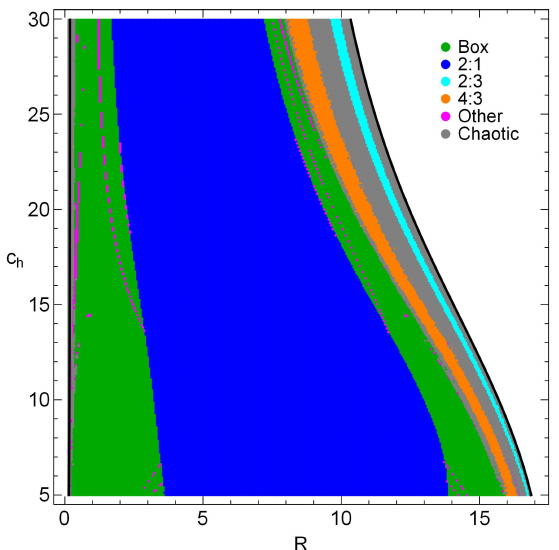
Fig. 7. Orbital structure of the ( R; c h ) plane. This diagram gives a detailed analysis of the evolution of orbits starting perpendicularly to the R -axis when the value of the halo scale length varies in the interval c h 2 [5 ;